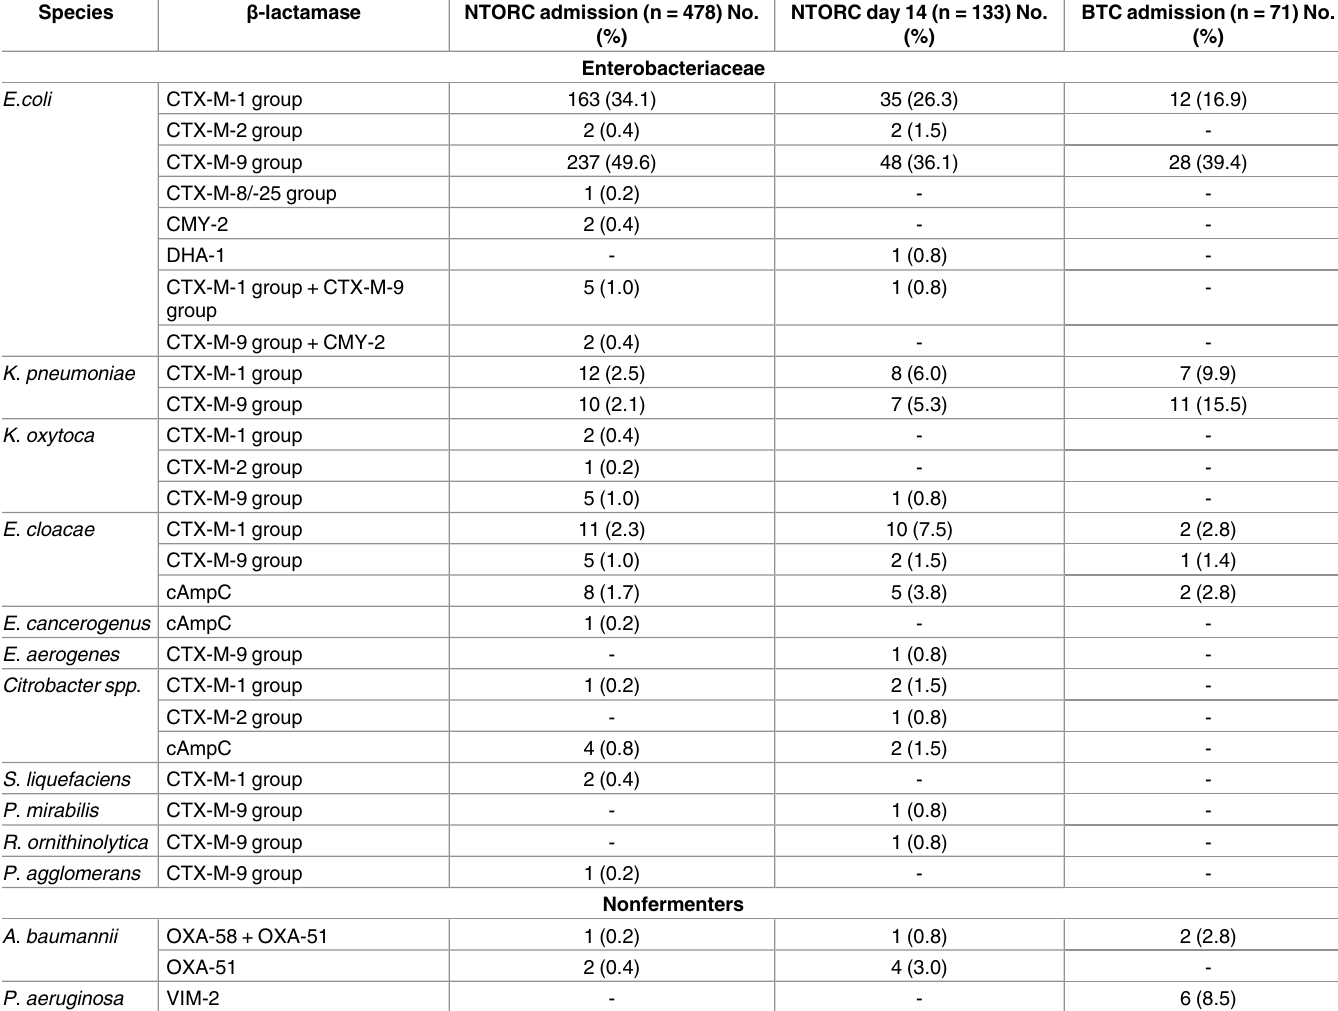
Table 3. GN-MDRO grouped by species and resistance mechanisms at the two sampling sites.